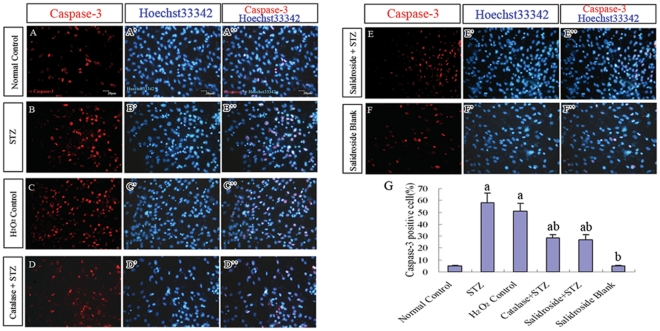
Immunofluorescence staining for cleaved caspase-3 (p17/19 active fragments) on NSCs.(A–F, A′–F′, A″–F″) Representative photomicrographs of caspase-3 immunoreactive cells (A–F) with their nuclei counterstained by the blue fluorescent nuclear stain Hoechst33342 (A′–F′) in six experimental groups: (A-A″) Normal control group, (B-B″) STZ group, (C-C″) H2O2 control group, (D-D″) Catalase+STZ group, (E-E″) Salidroside+STZ group and (F-F″) Salidroside blank group. (G) Bar chart showing the percentages of caspase-3 immunoreactive cells. Values are expressed as mean±SD. Numbers within bars represent the actual numerical reading on the y-axis. a
p<0.05 compared with the normal control group; b
p<0.05 compared with the STZ group.